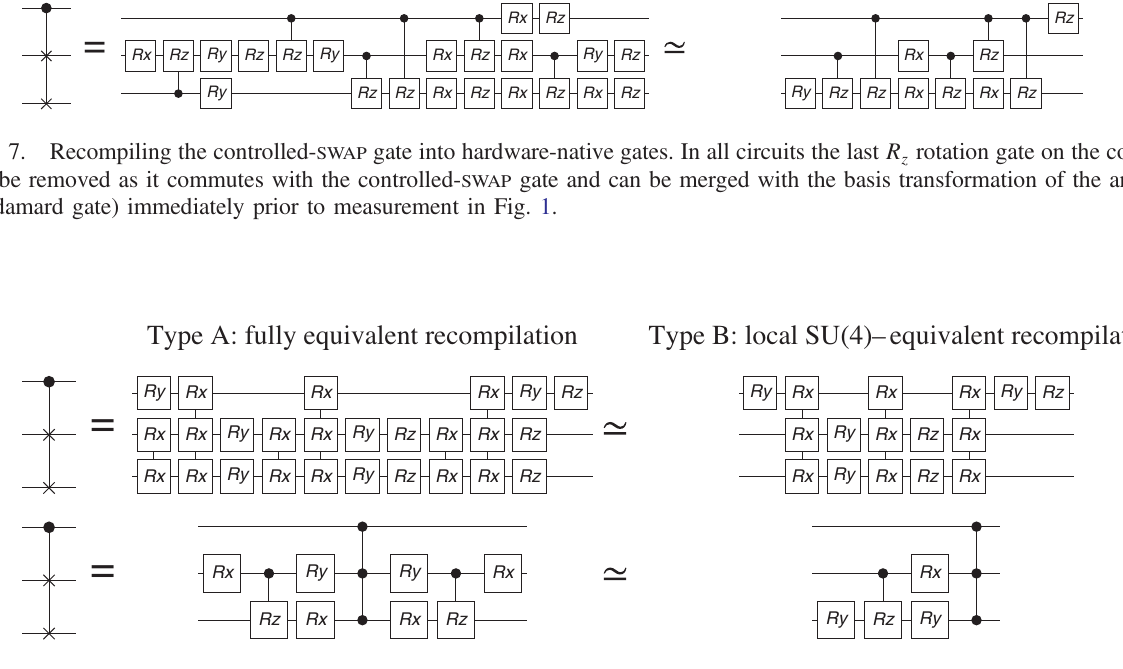
FIG. 8. Recompiling the controlled- SWAP gate assuming that the hardware can natively implement 3-qubit gates, such as the xxx gate (first row) and the controlled-controlled-phase gate (second row).